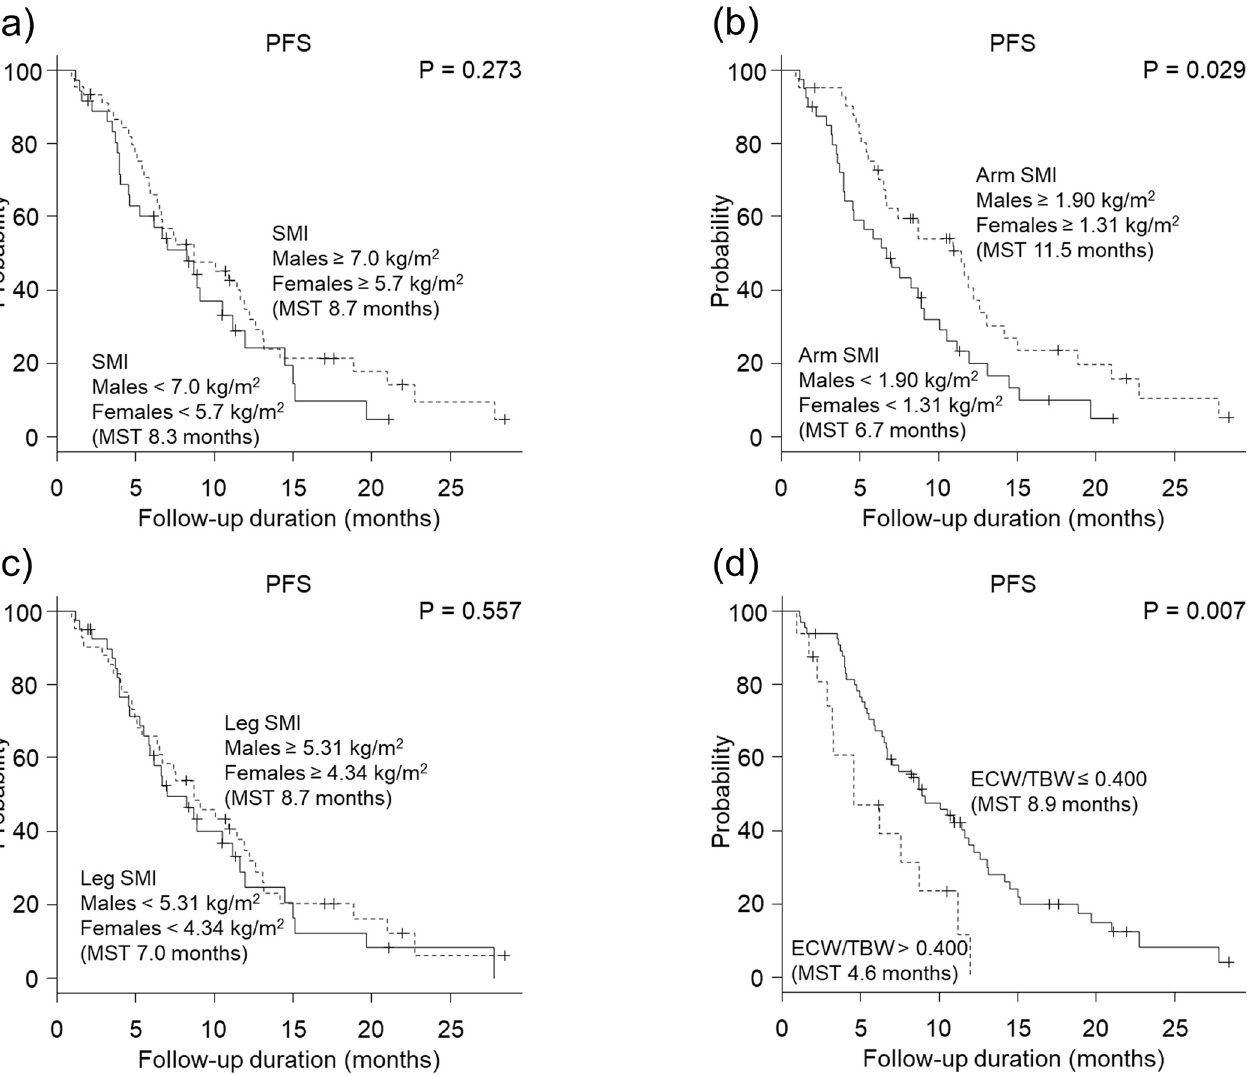
Fig 2. Association of each body composition measure with progression-free survival (PFS). (a) Total skeletal muscle mass index (SMI), (b) arm SMI, (c) leg SMI, and (d) extracellular water to total body water ratio (ECW/TBW). The cutoff for SMI was 7.0 kg/m 2 for males and 5.7 kg/m 2 for females, which aligns with the diagnostic criteria of the Japanese Society of Hepatology. The cutoff for arm SMI and leg SMI was the median value. (d) For ECW/TBW, patients with an ECW/TBW of � 0.400 experienced a significantly longer PFS than those with an ECW/TBW of > 0.400 (8.9 months vs 4.6 months, P = 0.007). (b) For arm SMI, patients with a value above the median arm SMI experienced a significantly longer PFS than those with a value under the median arm SMI (11.9 months vs 6.7 months, P = 0.029). (a, c) Total SMI and leg SMI were not associated with PFS (SMI, 8.3 months vs 8.7 months, P = 0.273; leg SMI, 7.0 months vs 8.3 months, P =